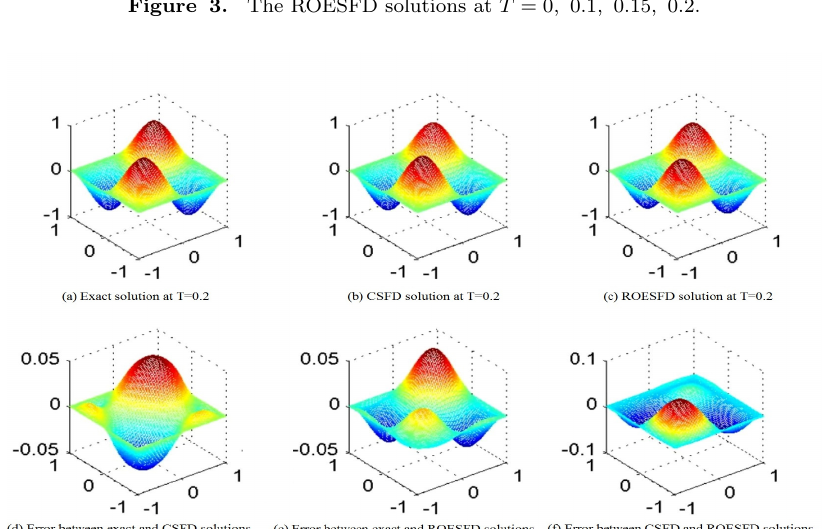
Figure 4. The exact, CSFD, ROESFD solution at T = 0 . 2 in the first line, the error between exact and CSFD solution, exact and ROESFD solution, CSFD and ROESFD solution at T = 0 .